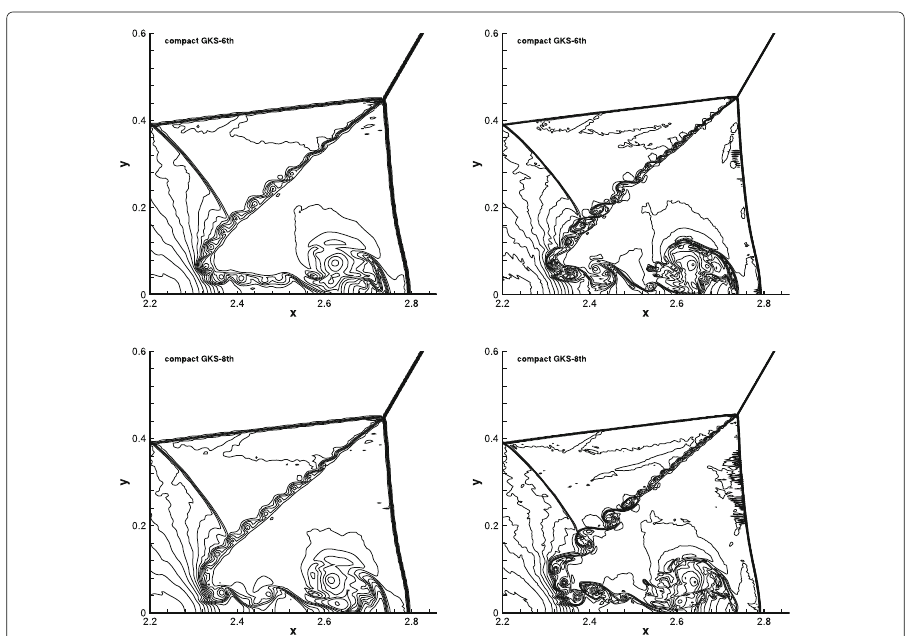
Fig. 14 Double Mach reflection: the local enlarged density distributions around the triple point of the 6th-order (up) and 8th-order (down) compact GKS with 960 × 240 (left) and 1920 × 480 (right) mesh points